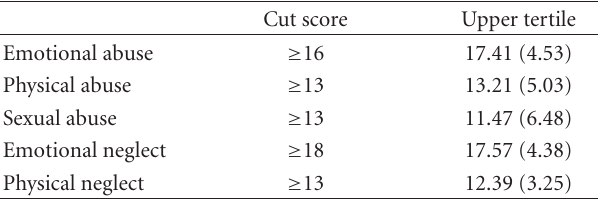
Table 2: Childhood trauma questionnaire normative cut scores for severe-to-extreme abuse.